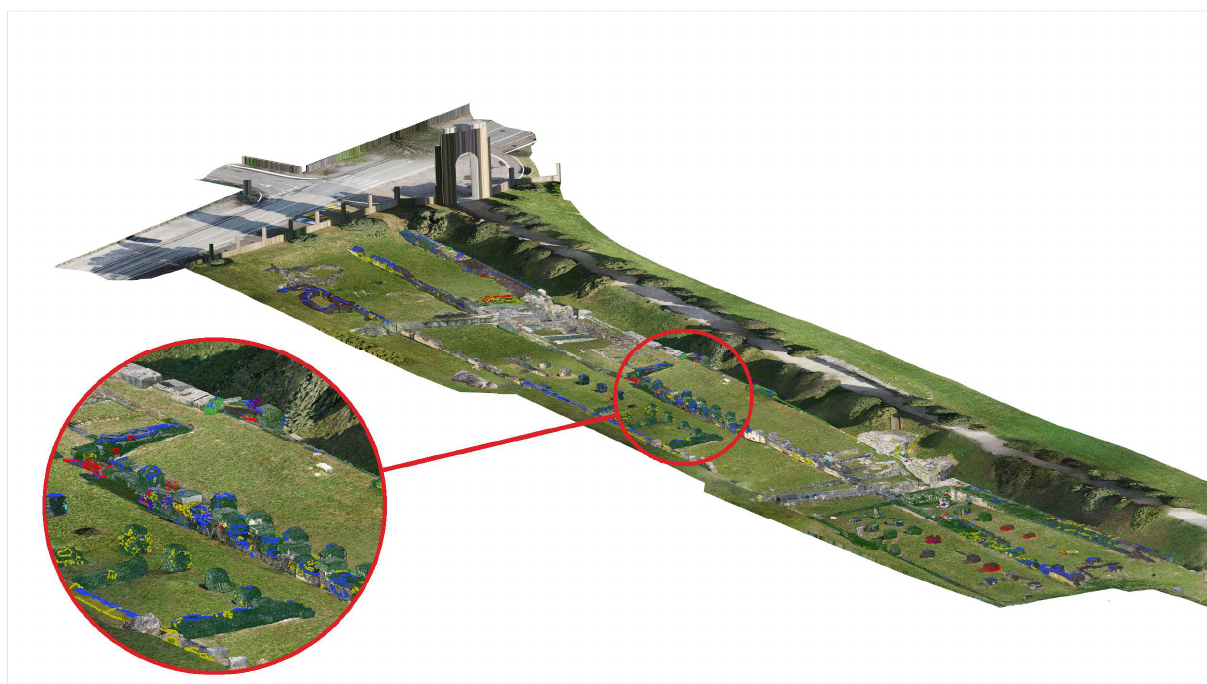
Figure 12. Render of all the segmentations of the various forms of degradation produced by the 36